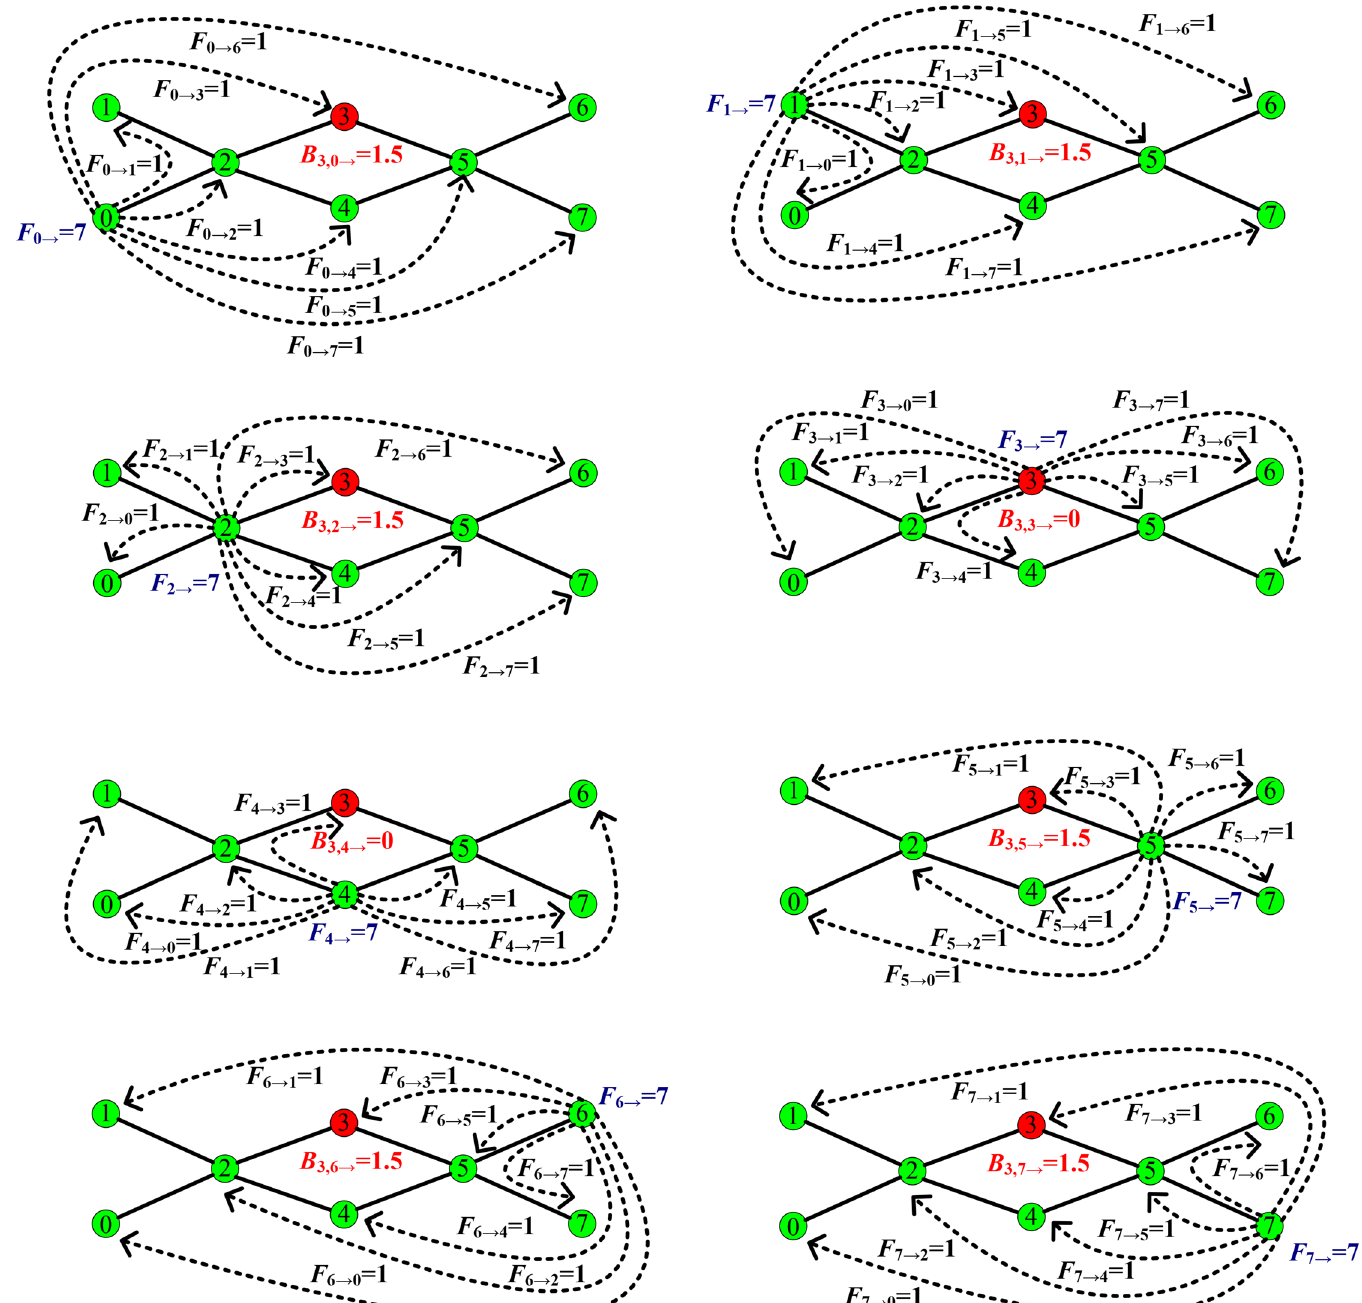
Fig 1. The calculation of the load transported by a node in previous work. In the betweenness method, assume that the load was transmitted along the shortest path between every pair of nodes. If calculating the initial load on a node, we need to count the effect of the load transmitted between all pairs of nodes on this node. For example, we calculate the load on node 3. We use F i ! j and B m , i ! to denote the load transported from node i to j and the load passing through node m in all load generated by node i , respectively. By calculating the load passing through node 3 and generated by every node, we get B B B B B B B B 3,0 ! = 1.5, 3,1 ! = 1.5, 3,2 ! = 1.5, 3,3 ! = 0, 3,4 ! = 1.5, 3,5 ! = 1.5, 3,6 ! = 1.5, and 3,7 ! = 1.5. Therefore, we can obtain the total load transported by node